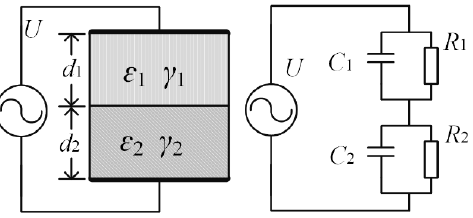
Figure 15. Equivalent circuit diagram of double-layer oil-paper insulation.